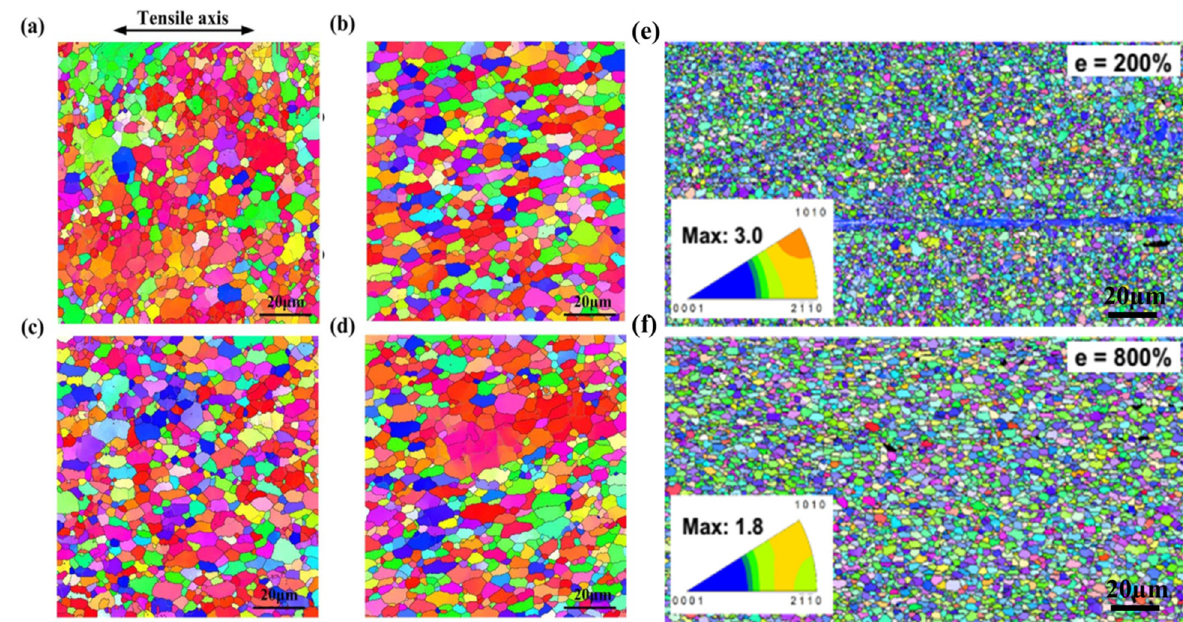
Figure 4. IPF maps of ZK60 Mg alloy: ( a ) grip section; ( b – d ) gauge section of ED, TD and 45D specimens, respectively, at a temperature of 275 °C [26]; ( e , f ) IPF maps of extruded ZK60 Mg alloys at elongation 200% and 800% at temperature of 250 °C at a strain rate of 0.01 s − 1 [17].